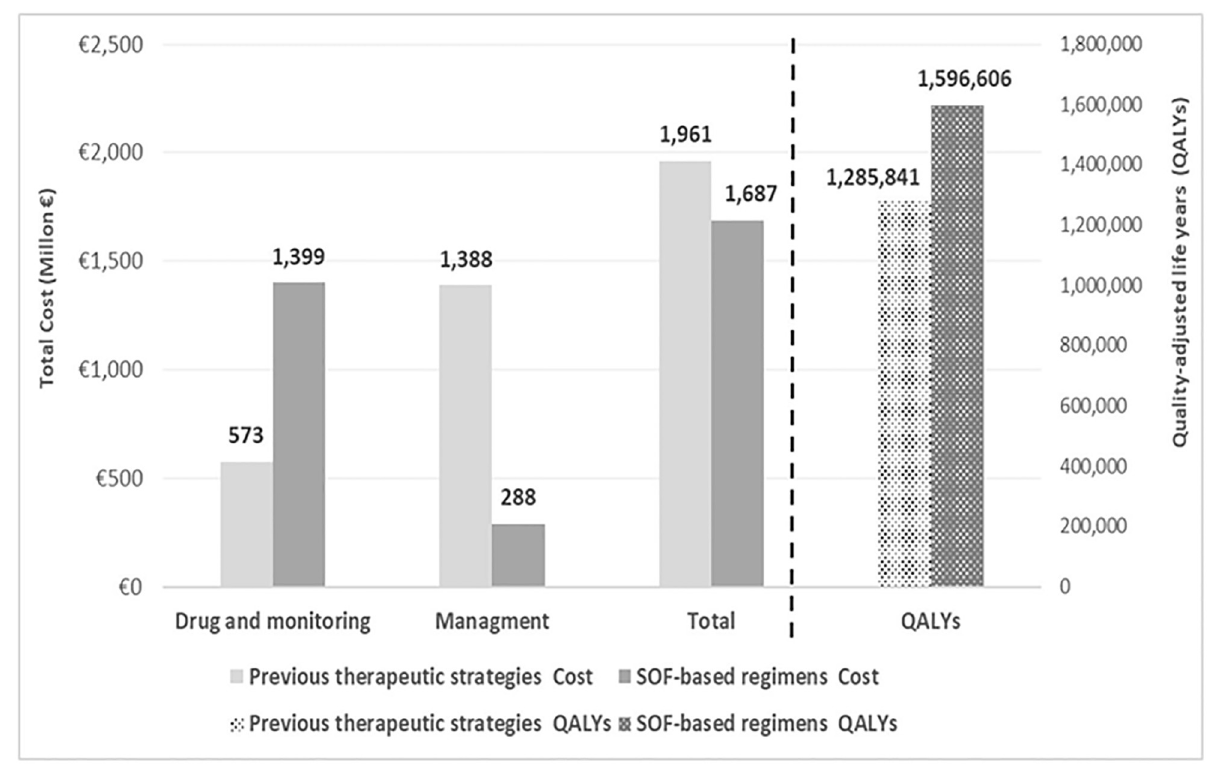
Fig 3. Cost-effectiveness results for the total cohort. SOF, sofosbuvir; QALYs, Quality-adjusted life